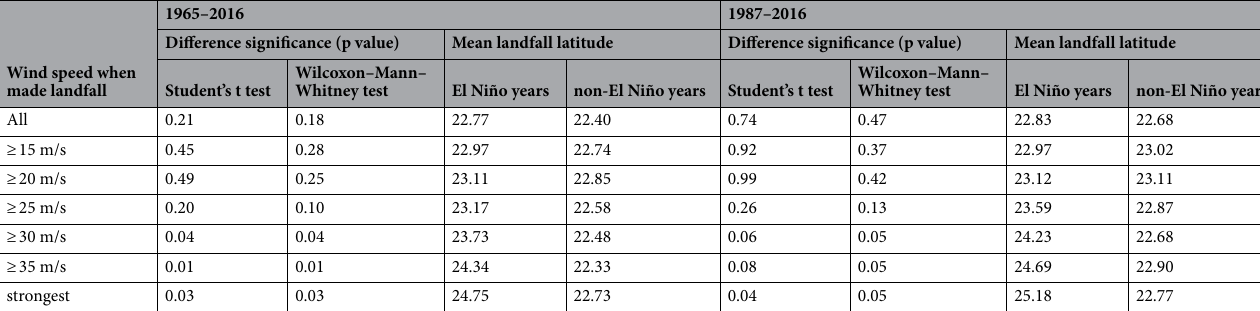
Table 1. Latitude of typhoon landfalling locations in the southeast Chinese mainland.